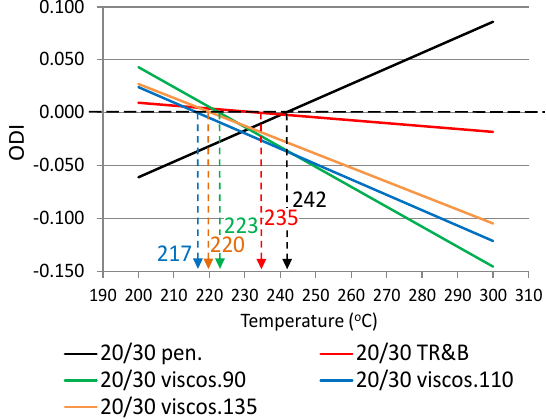
Figure 4. Overheating Degradation Index for binder 35/50 and determination of temperature T (ODI) .